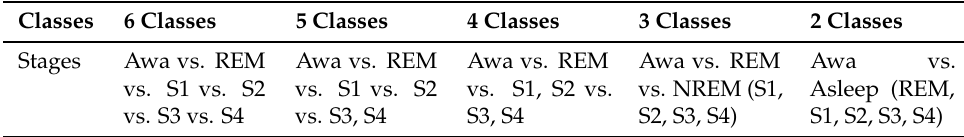
Table 1. The class description considered in this work under the Rechtschaffen’s and Kale’s (R&K) standard.